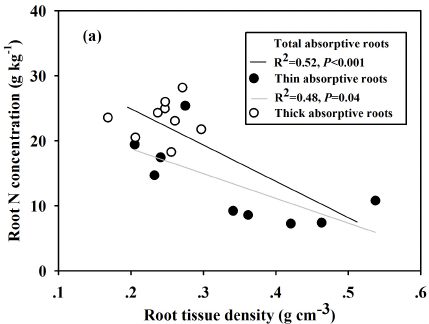
Figure 1. Relationships between root tissue density and root N con- centration for total (black line), thin (solid circles, grey line), and thick (open circles) absorptive